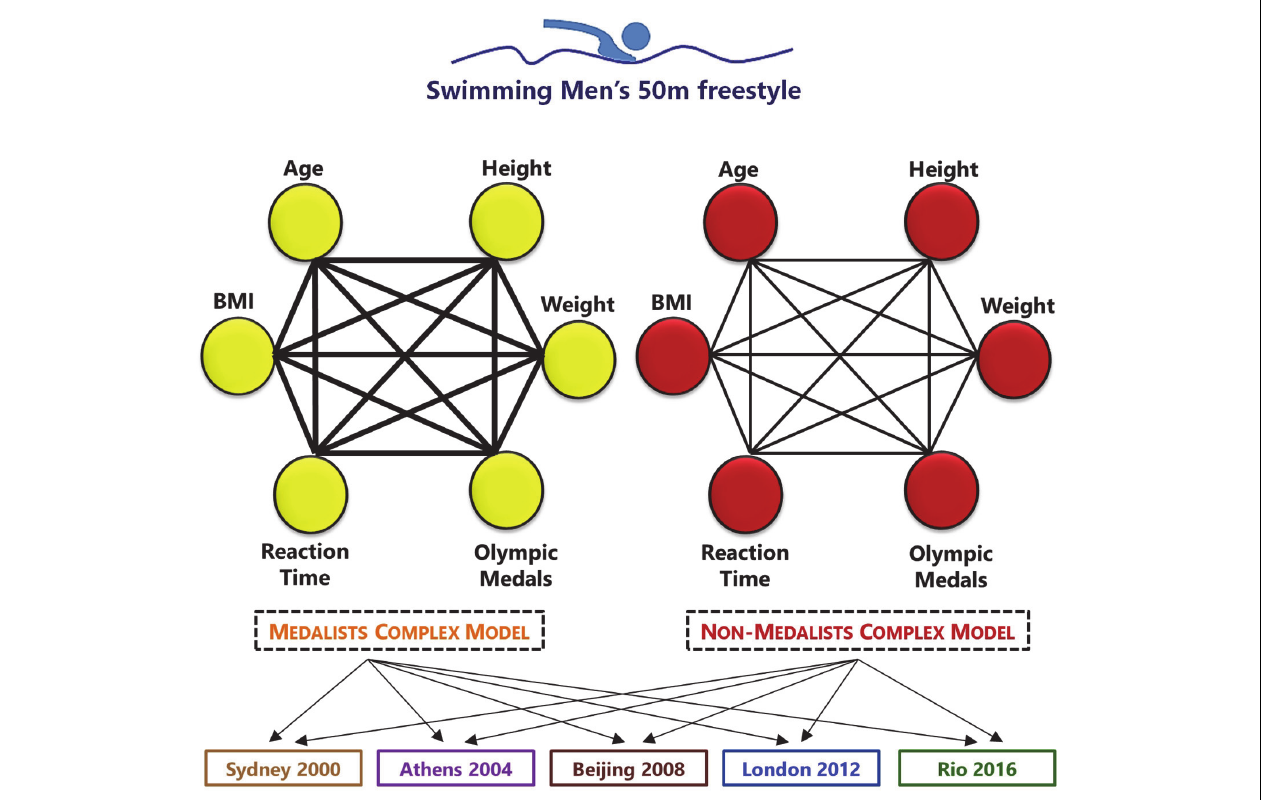
FIGURE 2 | Complex network model parameters (nodes and links) representation proposed for Medalists (yellow) and non-medalists (red) athletes. Every edition of the games results in two complex models. They are: The 2000 Olympic Games, which took place at Australia, in Sydney; 2004 Olympic Games, which took place in Greece, at Athens city; the 2008 Olympic Games, which took place in China, in Beijing; the 2012 Olympic Games, which took place in United Kingdom, in London; and the 2016 Olympic Games, which took place in Brazil, in the city of Rio de Janeiro. The finalists of the 50 m freestyle male swimmers were considered, relating 6 transformed variables into nodes – colored (Age, Height, Weight, BMI, Number of Olympic Medals and Reaction Time) and their weighted links (black) through the resulting correlation. The links of the Medalists complex models had higher weighted